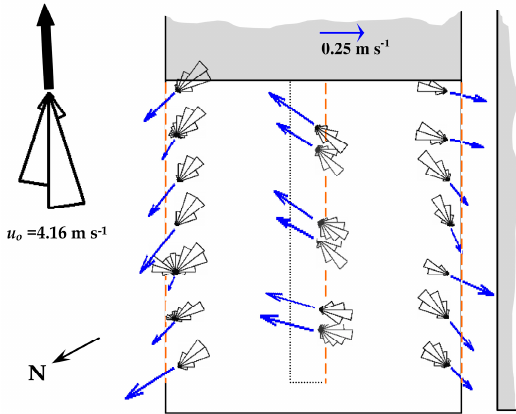
Figure 4. Polar histograms of the horizontal angle and projection of the air velocity (plane XY) at the side vents (middle of the vent) and at the roof vent of the western sector of the experimental greenhouse in conditions of moderate southwest wind (SW). Test 2 on 08/04/2009.